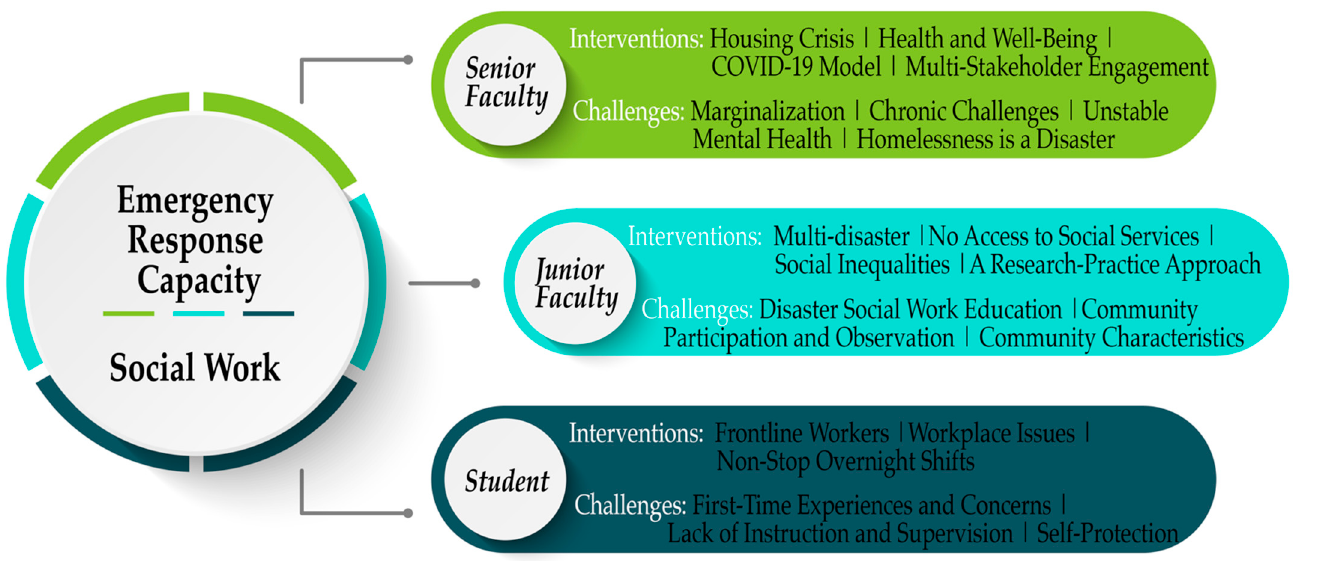
Figure 1. Data analysis structure. The three bars (senior faculty, junior faculty, and student) demon- strate the three authors’ critical reflection sub-themes that emerged in the data analysis regarding social work practice supporting PEHs. Under each sub-theme, bi-level sub-categories were developed to provide detailed supportive information, namely interventions and challenges. Different codes followed each subtheme.